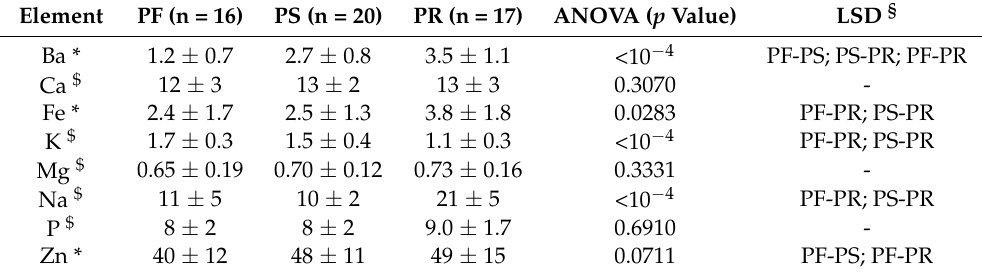
Table 2. Mean concentrations and related standard deviations of the detected elements in the Pecorino cheese samples. Significance ( p -value) of difference in the means determined by one-way ANOVA and list of the significantly different class pairs according to LSD